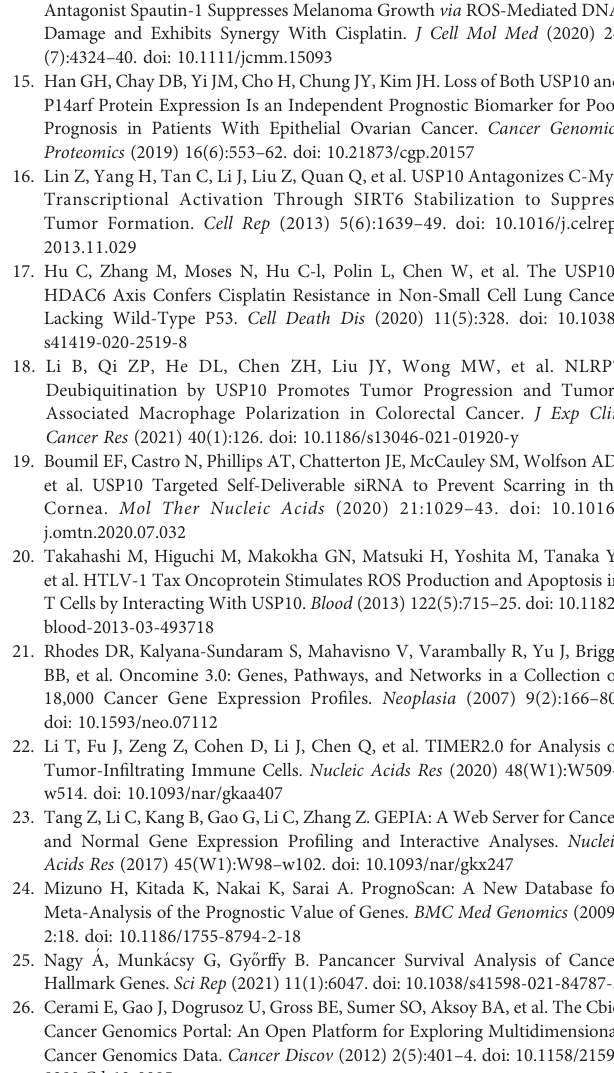
Supplementary Figure 2 | Protein expression of USP10 in cancers versus normal tissues as assessed in the HPA database. Compared to normal tissues, USP10 was signi fi cantly overexpressed in breast cancer, liver cancer, lung cancer, skin cancer, colon cancer, kidney cancer, and prostate cancer tissues. However, in ovarian cancer, there was a signi fi cant low expression of USP10 in tumor tissues compared with that in normal tissues. N, normal tissues; T, tumor tissues. Supplementary Figure 3 | TIMER database analysis of the correlation between USP10 expression and immune cell in fi ltration levels in different cancer types. USP10 expression levels in PAAD, LIHC, PCPG, PRAD, THCA, KIRC, and BLCA generally correlated positively with immune cell in fi ltration. However, in ACC, CHOL, HNSC-HPV+, UCEC, and UCS, USP10 expression levels were not signi fi cantly correlated with in fi ltration of B cells, CD4+ T cells, CD8+ T cells, macrophages, neutrophils, and dendriticcells. Redbox, positive Spearman ’ scorrelation; blue box,